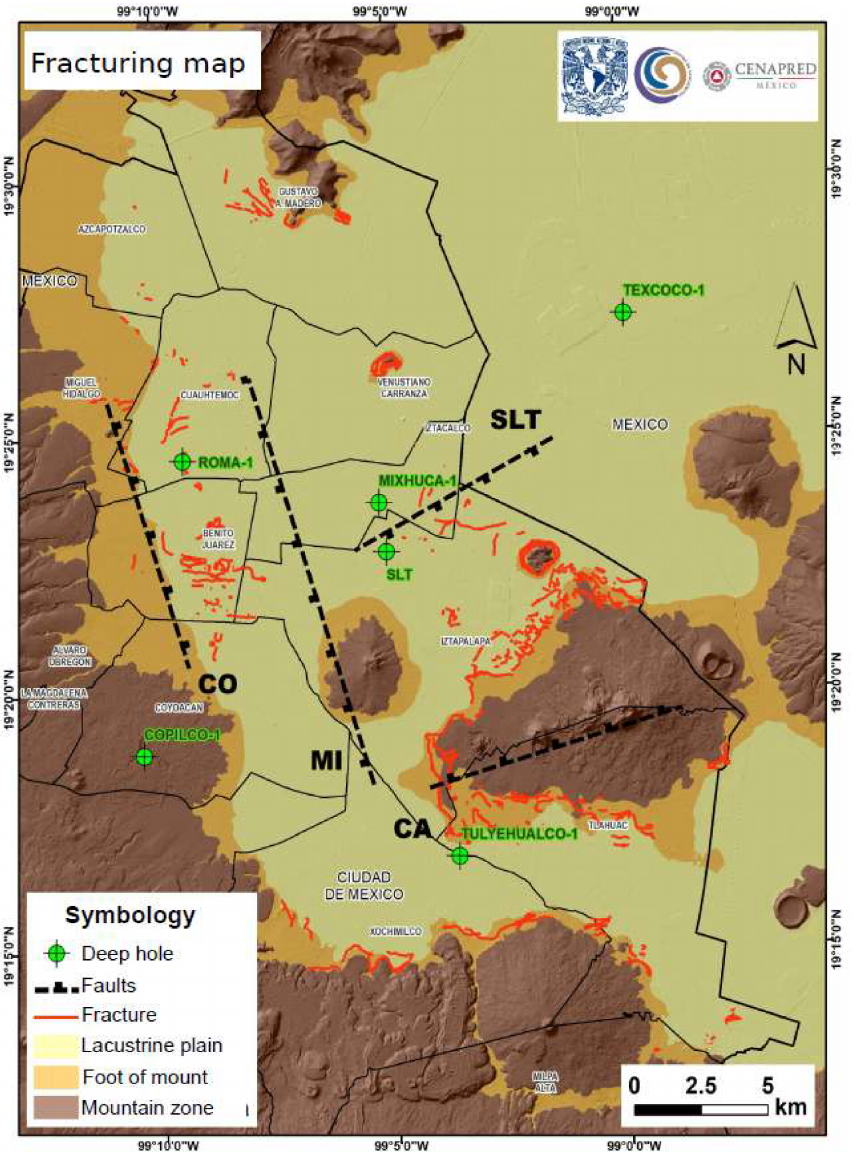
Figure 2. Ground fractures distribution in Mexico City (red lines) and main regional geological reported faults (black dotted lines) (Car- reón Freyre et al., 2017).